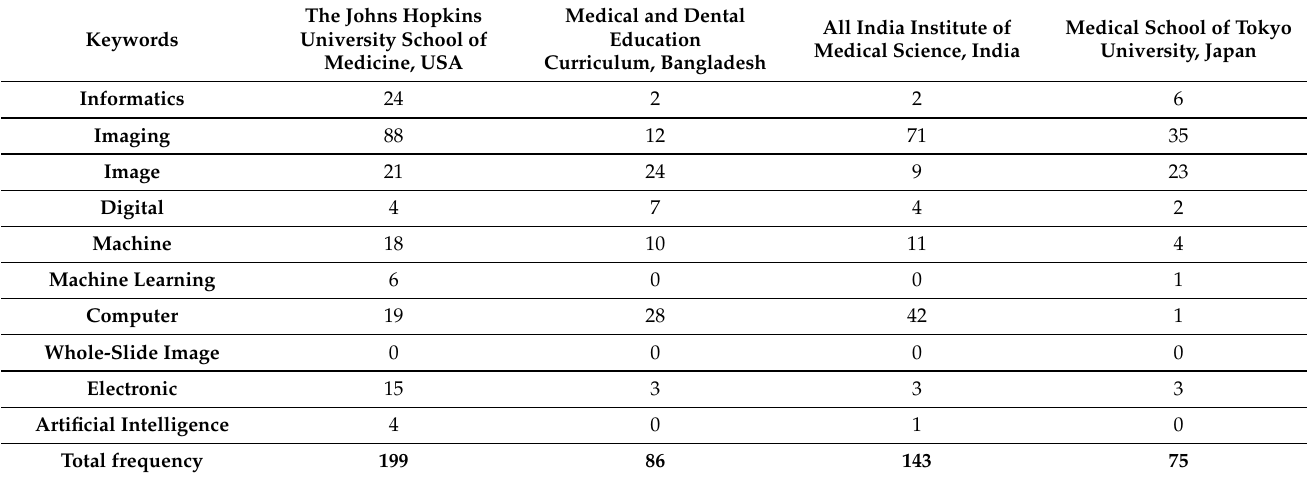
Table 4. Frequency of selected keywords in medical curricula and